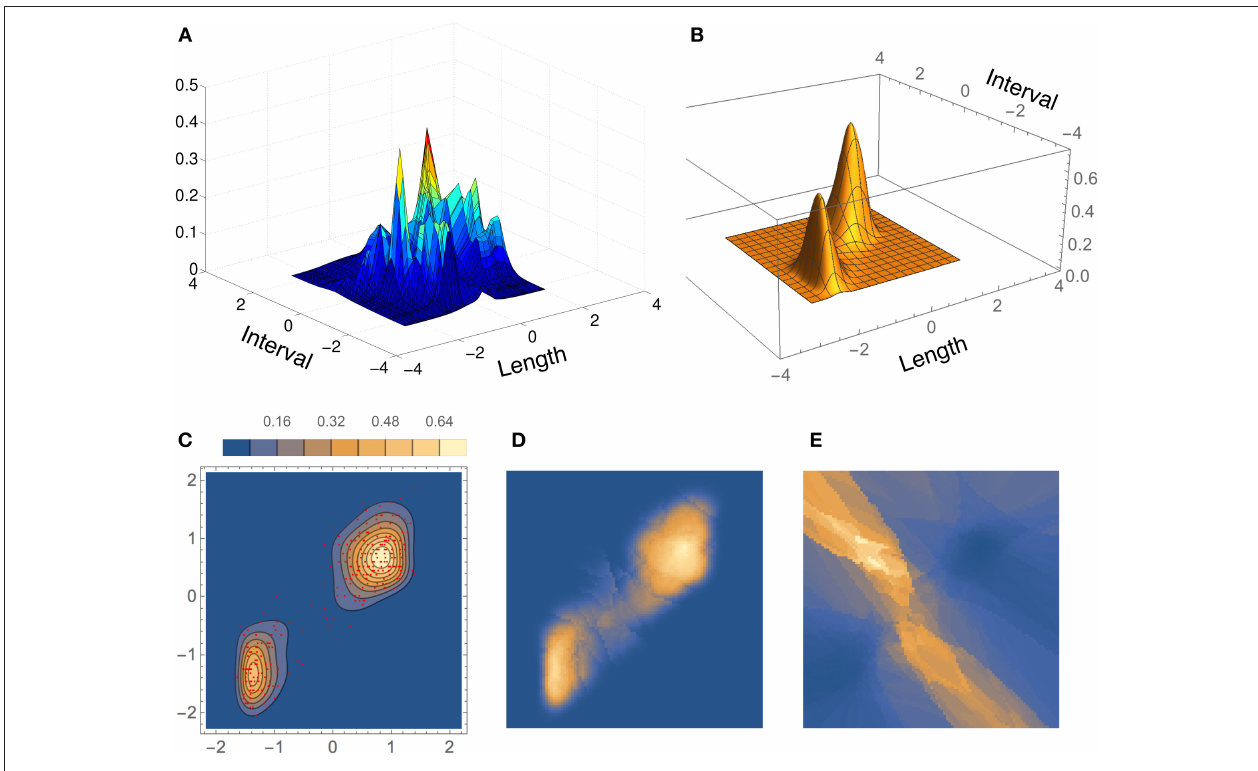
FIGURE 11 | Density estimates for the bivariate Old Faithful data set, comparing our method (BADE) with CAKE (Ganti and Gray, 2011). (A) CAKE estimate. (B) BADE estimate. (C) BADE estimate shown as a contour plot, along with the sample points. (D) Effective k values (i.e., k e ) on a grid of size 100 V k on the same grid. Both k e and V k are the ones before applying the covariance smoothing